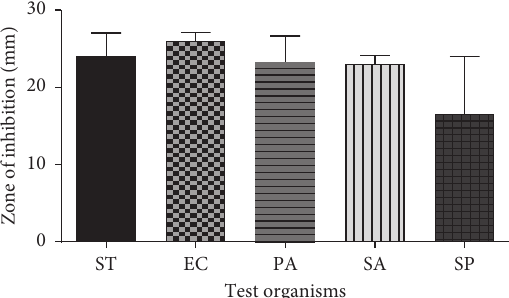
Figure 7: The inhibitory effect of 15% CFHE ointment on growth of Salmonella typhi (ST), Escherichia coli (EC), Pseudomonas aeruginosa (PA), Staphylococcus aureus (SA), and Streptococcus pyogenes (SP) in an agar diffusion test. Values are means ± SEM, ( n �